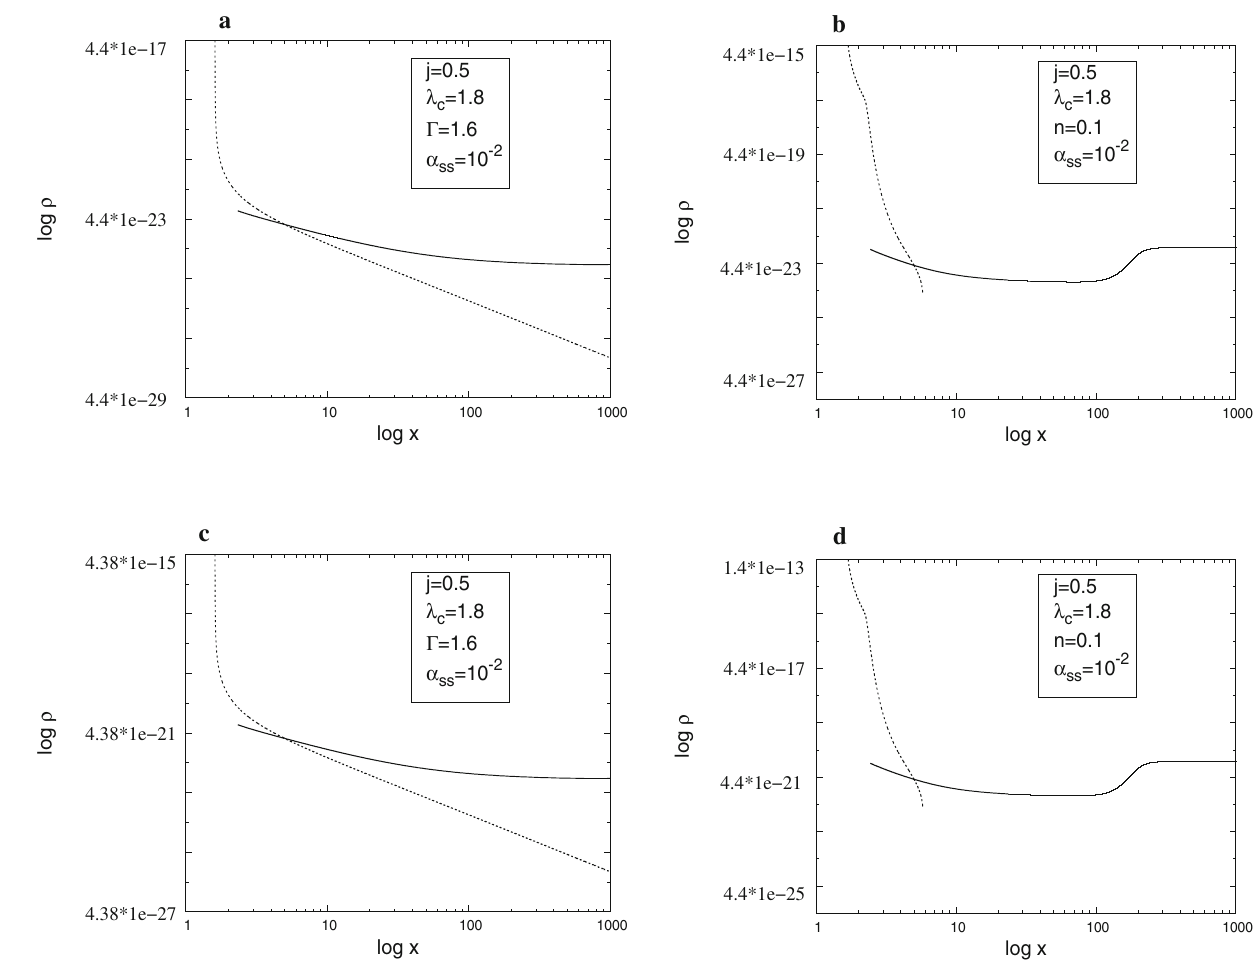
Fig. 7 a , c Plotsof log (ρ) vs log ( x ) fornonviscous accretiondiscflow around a non-rotating BH for adiabatic case using NFW and Einasto profile respevctively. b , d Plots of log (ρ) vs log ( x ) for viscous accre-